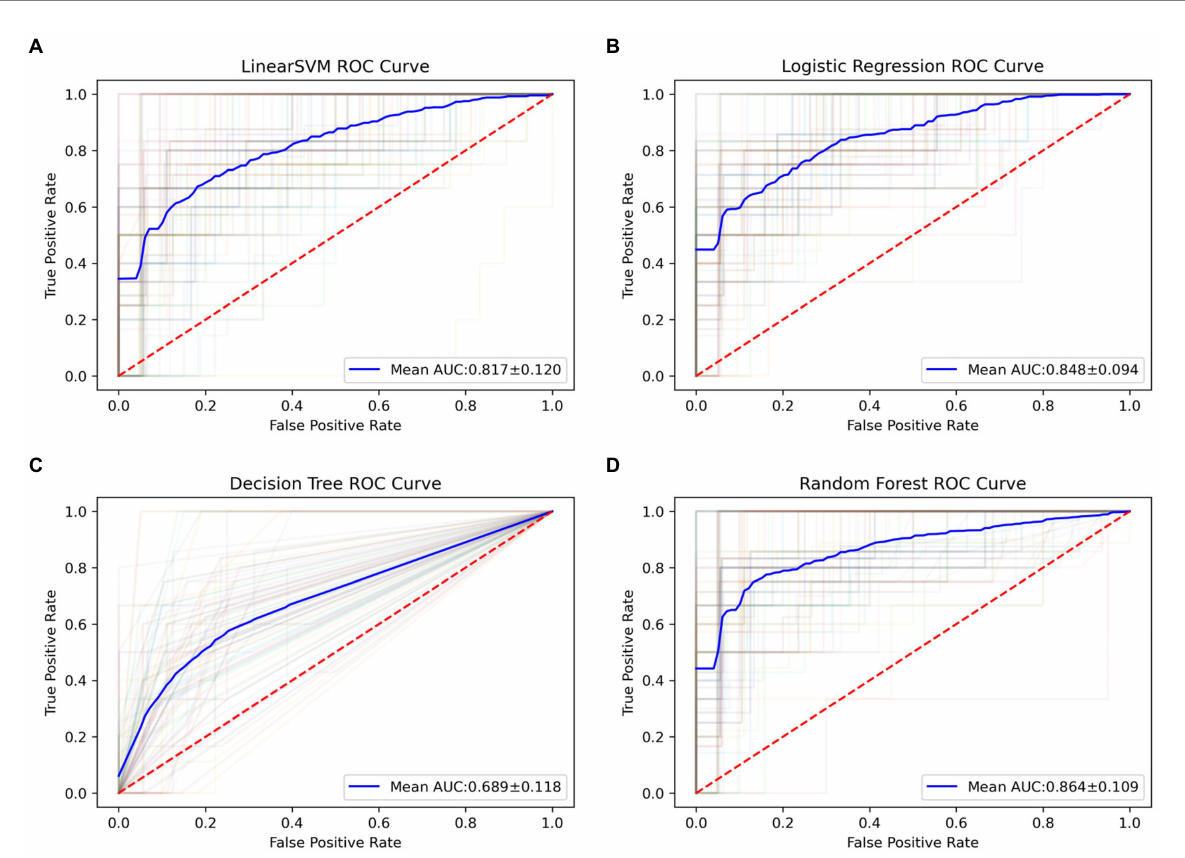
FIGURE 2 The ROC curves of all classification models in 100 runs of repeated re-divided dataset randomly. (A) The SVM model; (B) the logistic regression model; (C) the decision tree model; (D) the random forest model. AUC, an area under the curve; ROC, the receiver operating characteristic; SVM, support vector